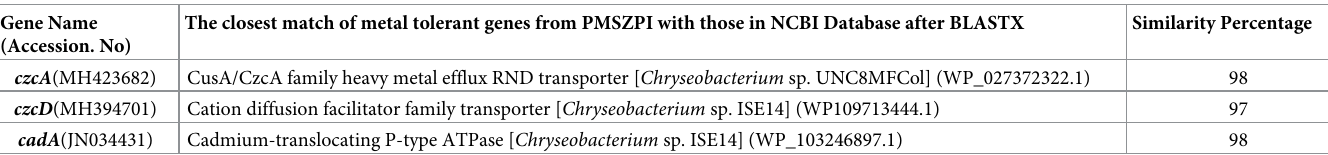
Table 2. BLASTX analysis of metal transporters from Chryseobacterium sp. (PMSZPI). Gene Name The closest match of metal tolerant genes from PMSZPI with those in NCBI Database after BLASTX (Accession. No)